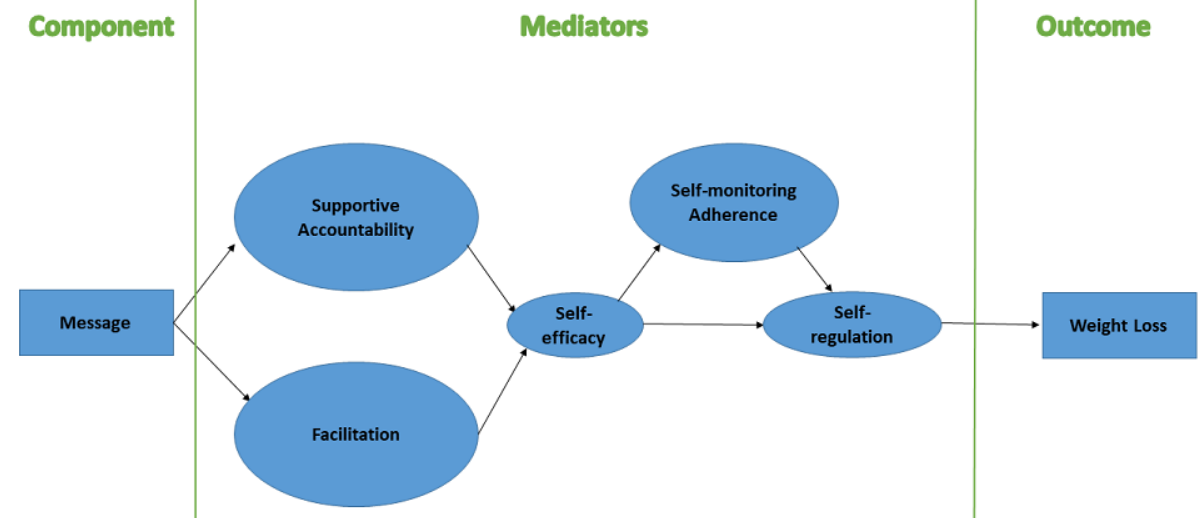
Figure 2. Optimization of Remotely Delivered INtensive Lifestyle Treatment for Obesity Study (Opt-IN) messaging conceptual